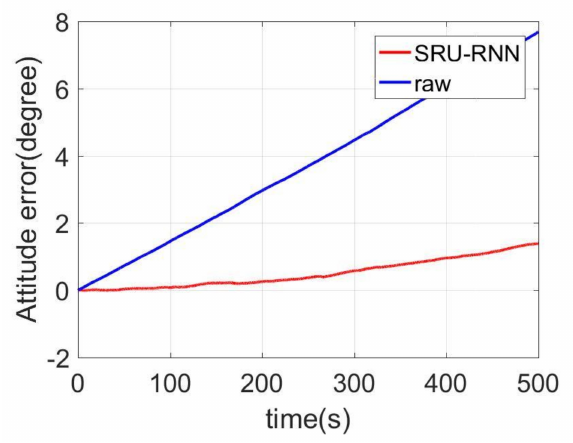
Figure 16. Roll angle errors comparison.